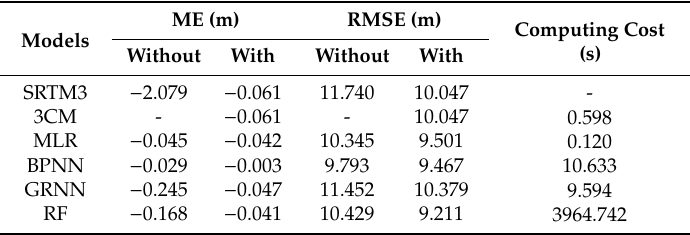
Table 2. Performance comparison between the correction models for SRTM3 DEM with and without data coregistration relative to ICESat / GLAS data. 3CM represents the three dimensional (3D) coregistration method and MLR represents multiple linear regression. ME (m) RMSE (m) Computing Cost Models (s)Without With